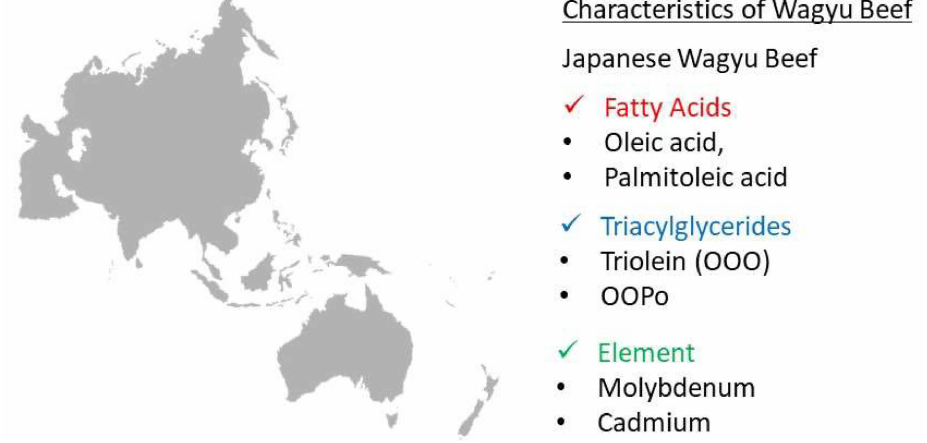
Figure 6. Characteristics of Wagyu breed determined via comparative analysis. A summary of the distinct components of Wagyu was obtained by lipid and elemental